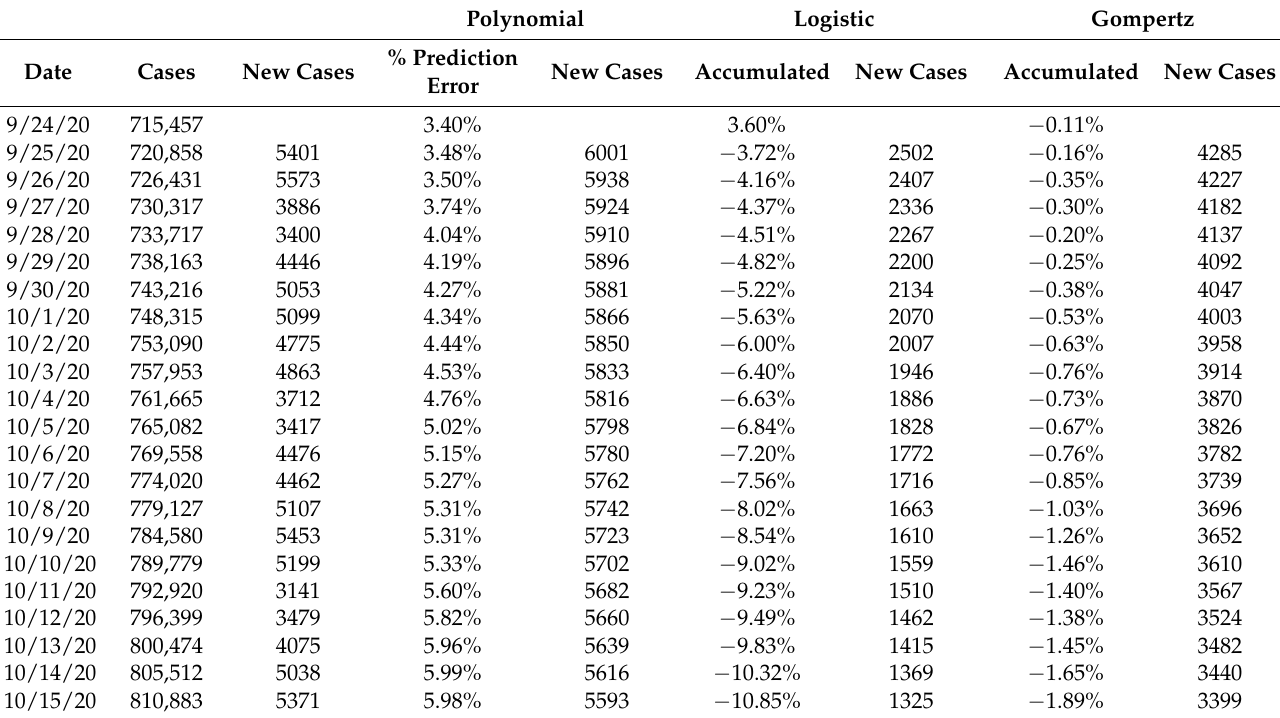
Table 5. Daily new COVID-19 cases predicted from total cumulative cases in